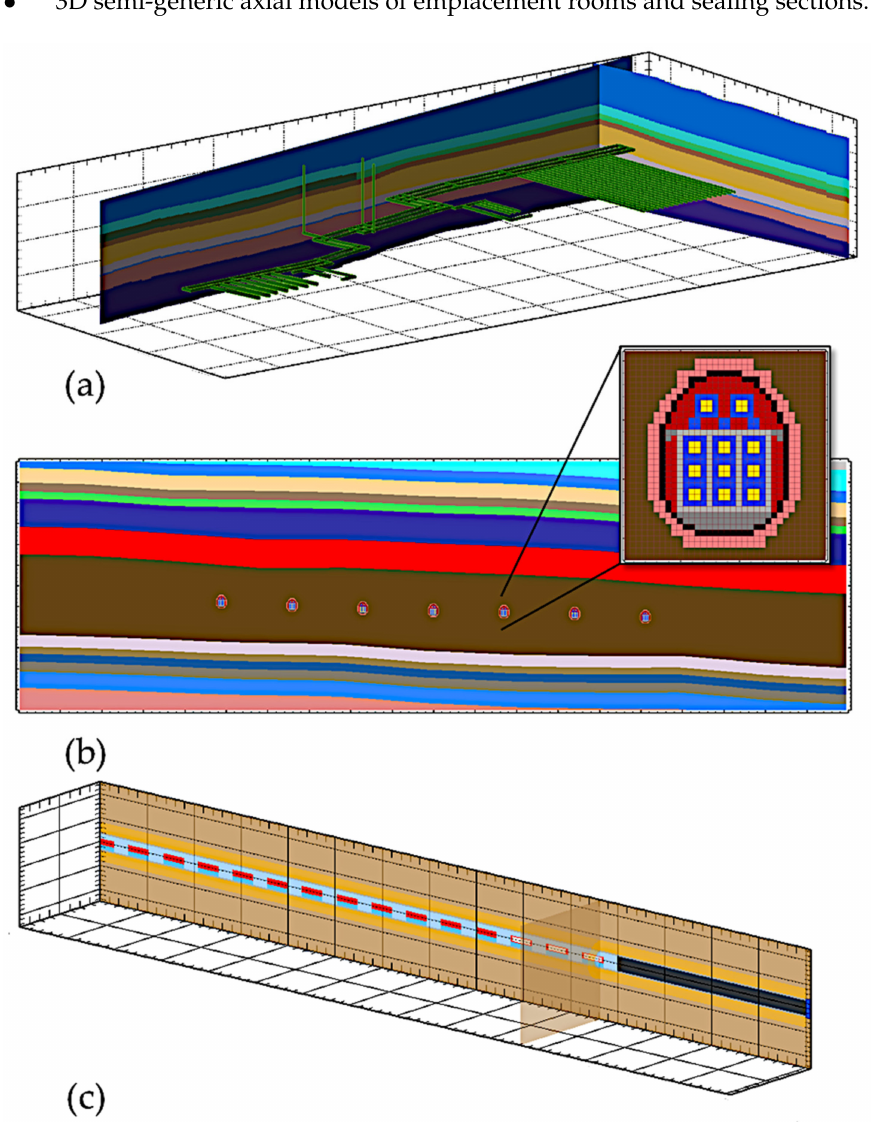
Figure 5. Examples of models used for the site-specific assessments of geological barriers: ( a ) 3D model of combined L/ILW and HLW repository; ( b ) 2D sub-model of vertical cross-section through the L/ILW repository; ( c ) 3D semi-generic model of HLW emplacement tunnel with seal and connecting